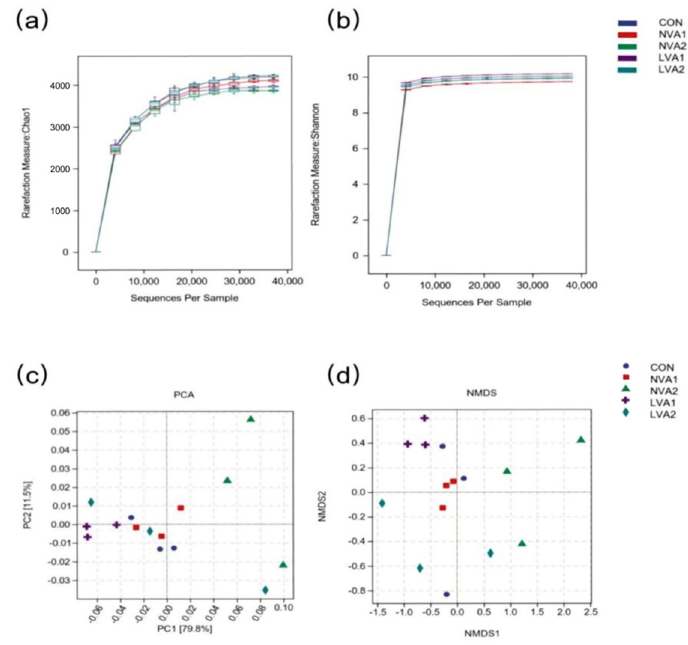
Figure 4. Changes in the intestinal flora diversity of Yanbian yellow cattle after vitamin A feeding. The α diversity analysis was carried out, including Chao1 richness estimator ( a ) and Shannon-wie- ner diversity index ( b ). β diversity analysis, including principal component analysis (PC)( c ) and non-metric multidimensional scaling (NMDS)( d